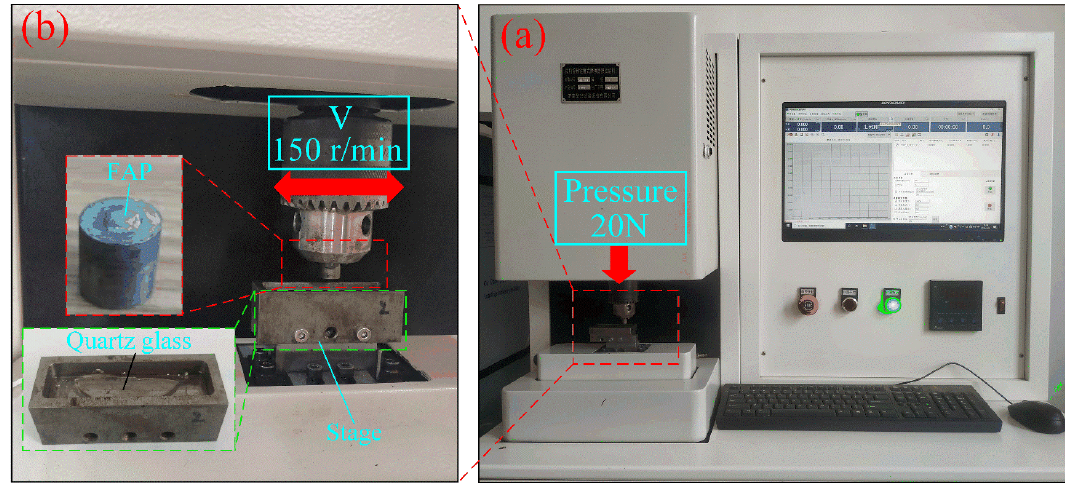
Figure 4. MWF-500 equipment and local amplification: ( a ) equipment working position; ( b ) test equipment.